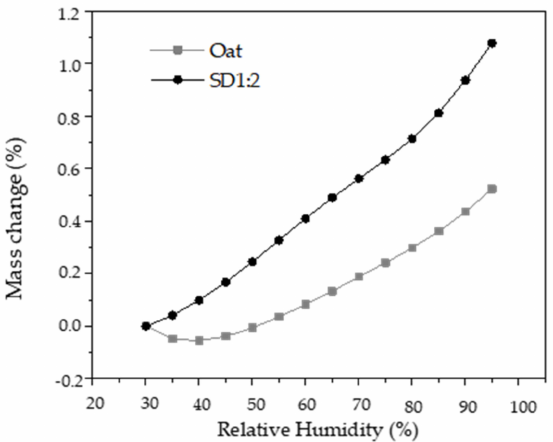
Figure 3. Dynamic vapor sorption isotherms of particles produced by spray drying (SD1:2) and oat flakes.